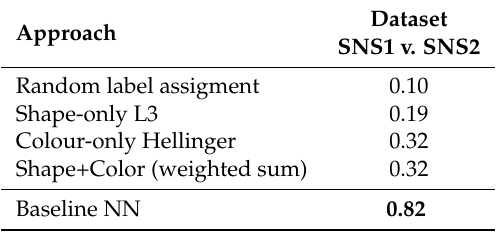
Table 3. Cumulative accuracy results, when views in SNS1 are matched against